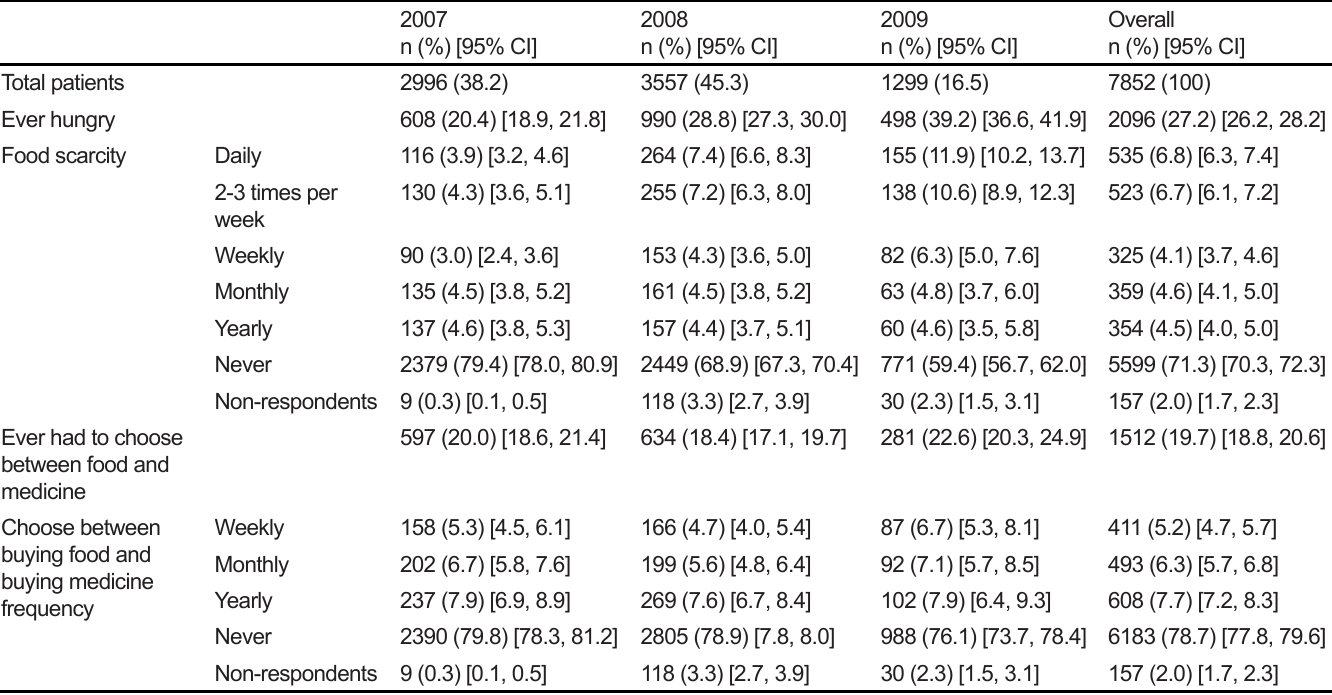
Table 2. Food insecurity of patients in the emergency department.